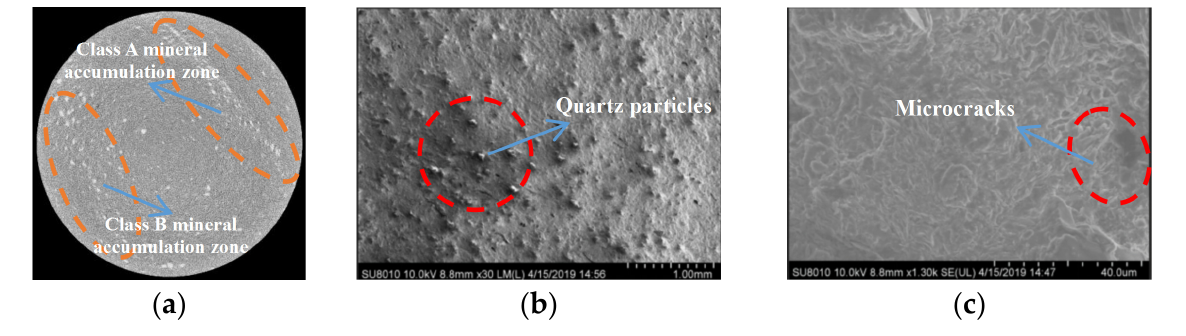
Figure 4. Microcracks and pores near mineral particles. ( a ) Mineral accumulation zone. ( b ) Quartz particles. ( c ) Microcracks near mineral particles.